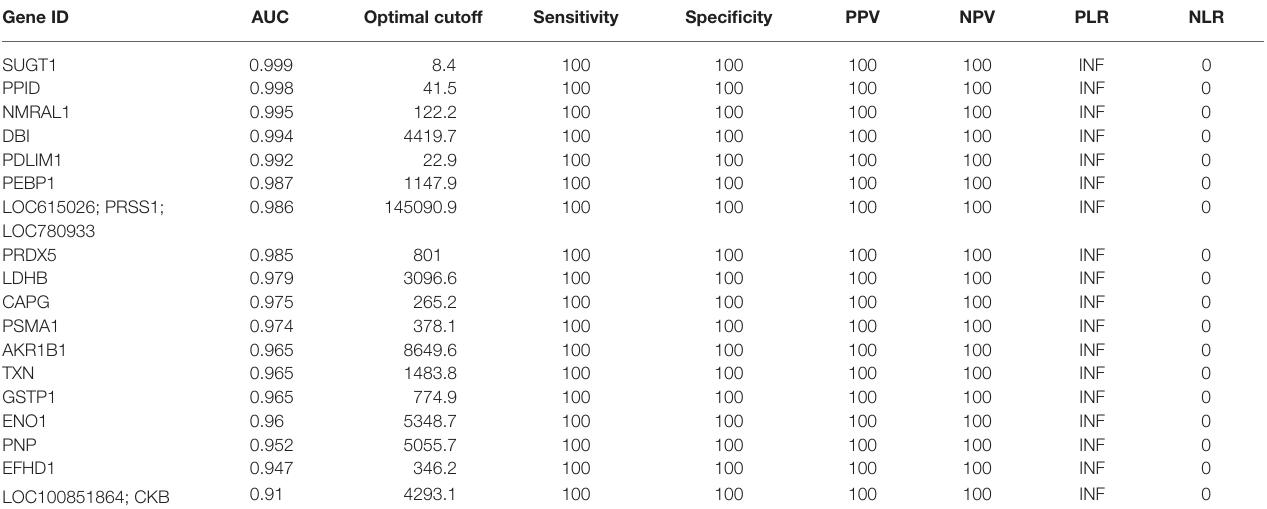
TABLE 1 | The list of parameters of factors identified by ROC